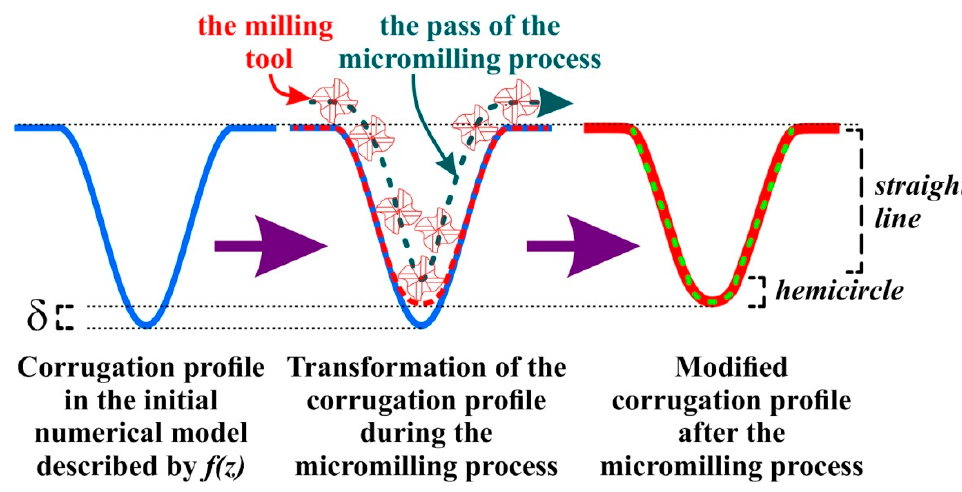
Figure 6. An illustration showing how the initial corrugation profile (in blue) changed throughout the micromilling fabrication process. The red color indicates the corrugation profile that has been adjusted following the micromilling operation. A dashed green line represents a simplified version of the corrugation profile, which includes the hemicircle and straight lines. ∆ indicates the difference between the corrugation depth in the original numerical model and the corrugation depth in the microfabricated sample of the interaction structure.